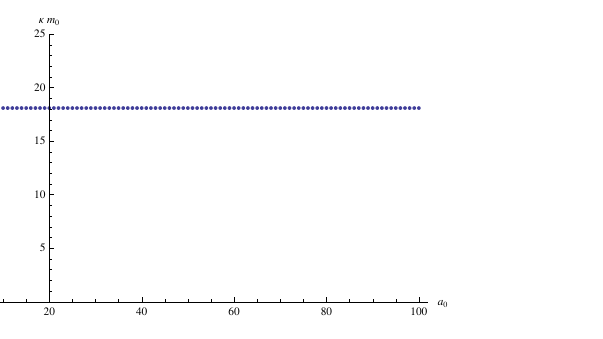
Figure 17 . The dependence of ^ m 0 on a 0 for (cid:11) = 0 : 05. The surface r s (cid:3) is located on the neck, r (cid:3) s = a (cid:3) . The plot shows that ^ m 0 is almost independent of a 0 .